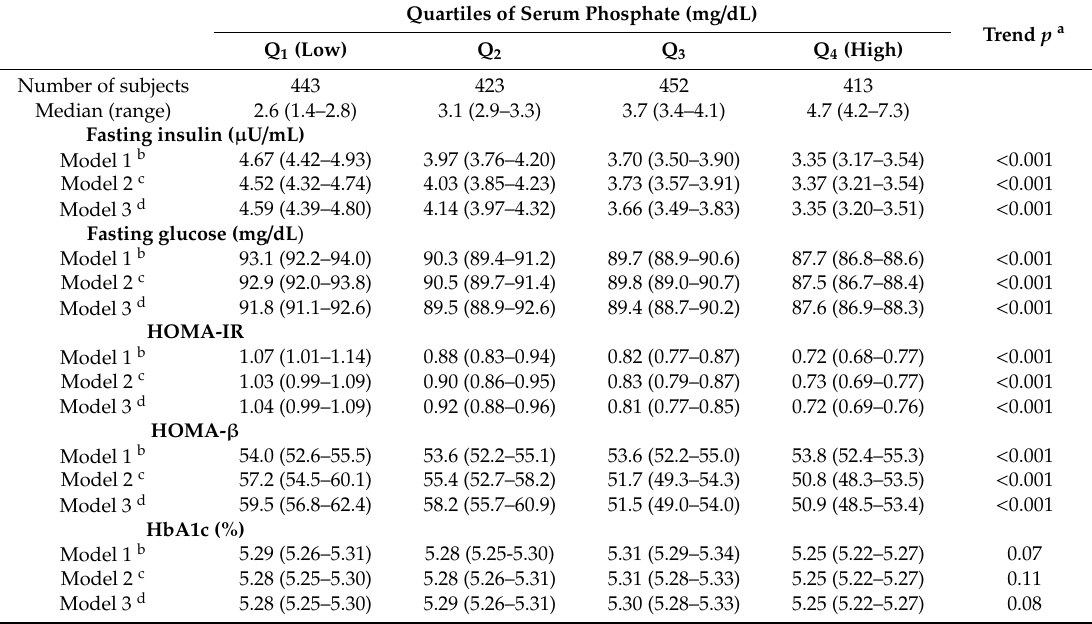
Table 3. Adjusted means (95% CI) of insulin, glucose, HOMA-IR, HOMA- β , and HbA1c across quartiles of serum phosphate.